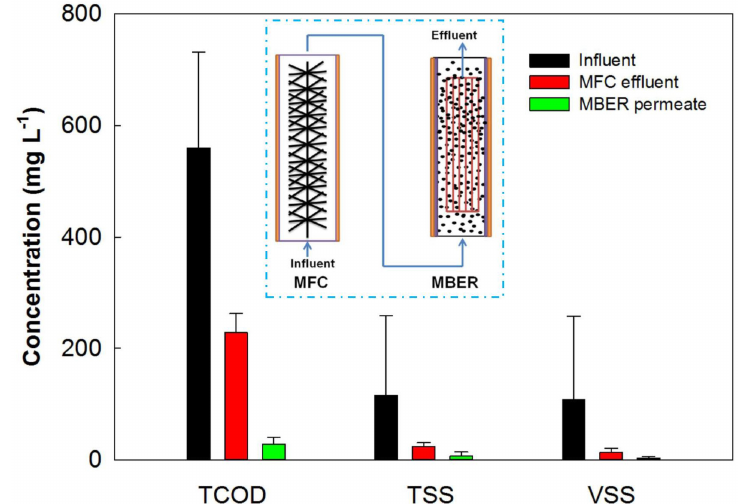
Figure 5. The contaminants removal from cheese wastewater by the coupled MFC–MBER system (see insert). TCOD: total COD; TSS: total suspended solids; VSS: volatile suspended solids. Reproduced with permission from reference